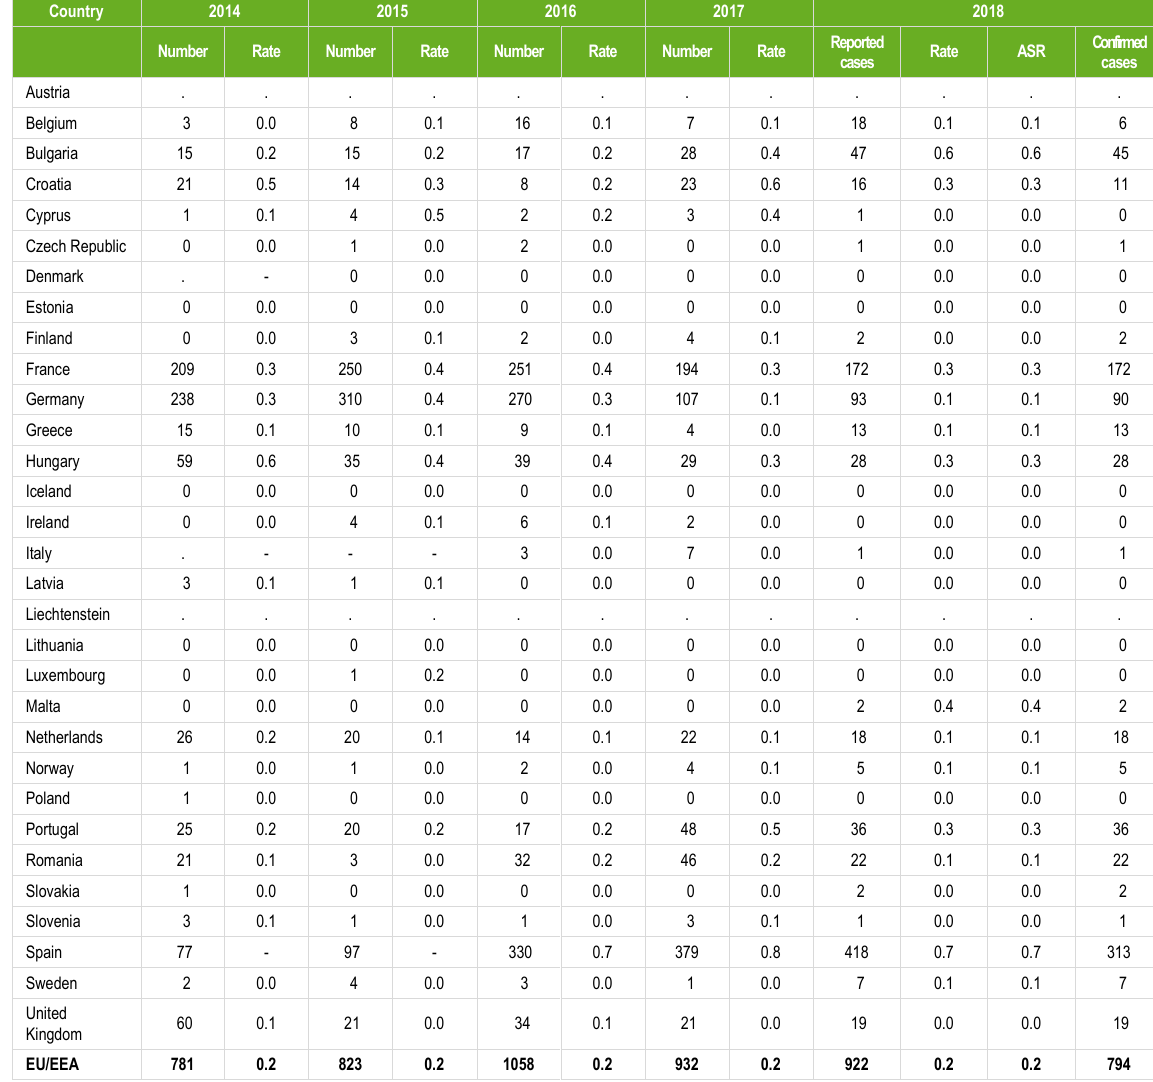
Table 1. Distribution of confirmed Q fever cases and rates per 100 000 population by country and year, EU/EEA,